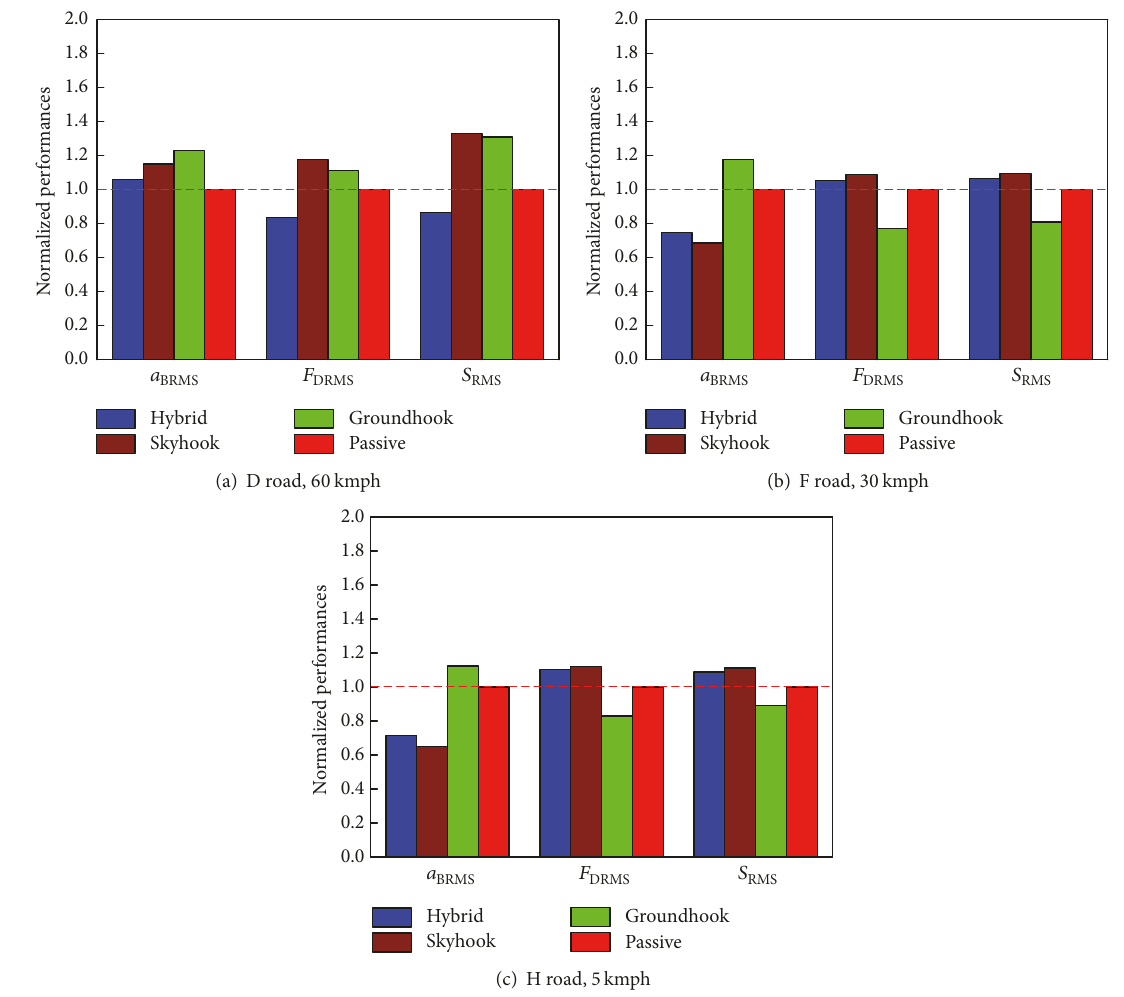
Figure 12: Comparison of normalized performances of different control